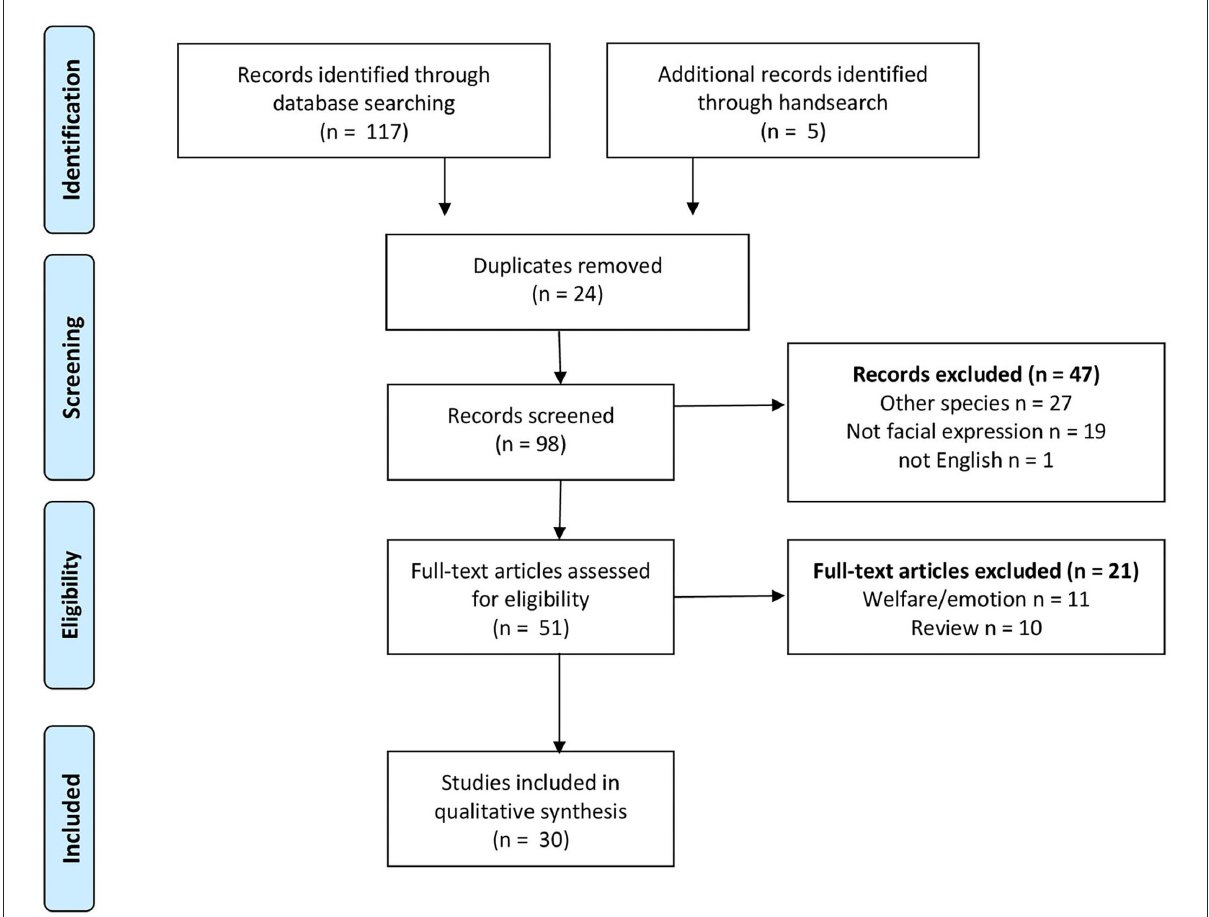
FIGURE1 Preferred Reporting Items for Systematic reviews and Meta-Analyses (PRISMA) flow diagram with the selection process of relevant articles